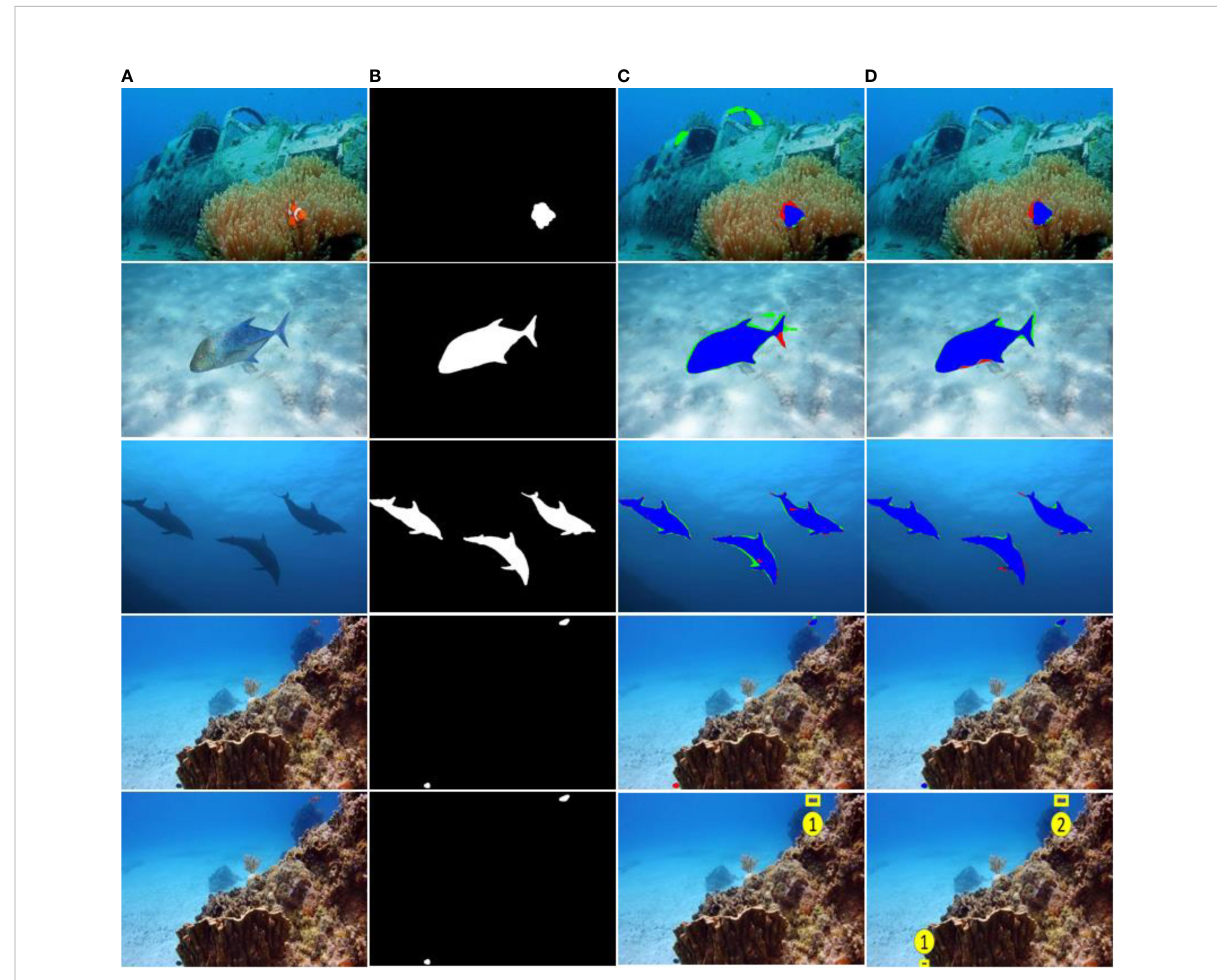
FIGURE 10 Good qualitative results by EFS-Net and MFAS-Net on the SUIM dataset. Rows 1-4: Segmentation results; (A) original test image, (B) ground truth image, (C) segmented images achieved by applying EFS-Net, and (D) segmented images achieved by MFAS-Net (the fp and tp pixels are referred by green and blue colors, respectively. Pixel representation for fn is done with red color). Row 5: segmentation-based fi sh detection and